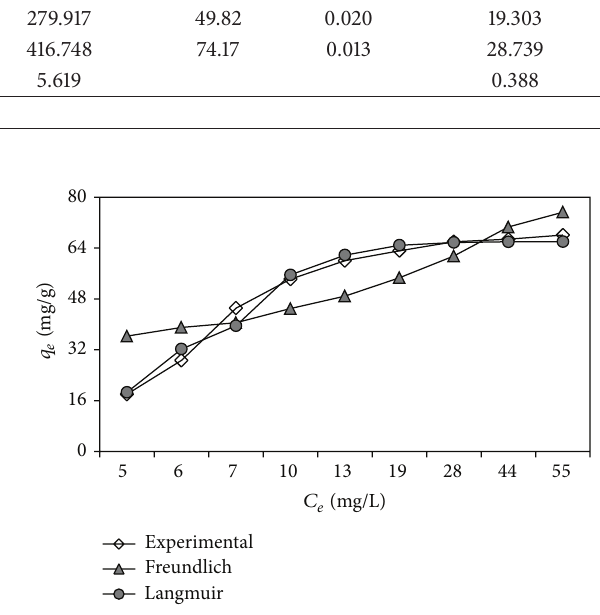
Figure 5: Plots for biosorption isotherm